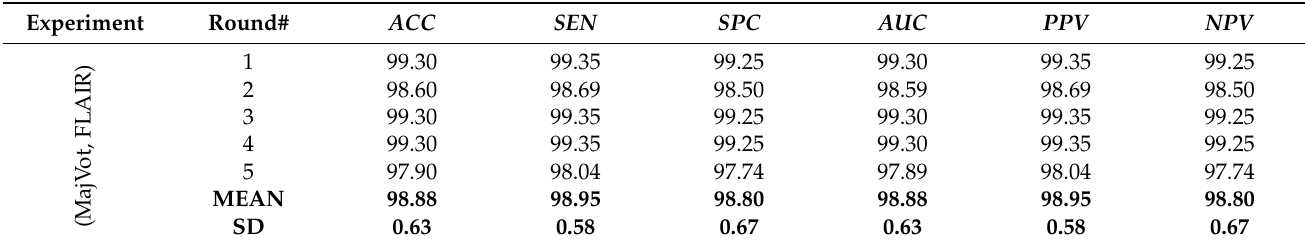
Table A20. Test results of five-folds of the experiment (MajVot,